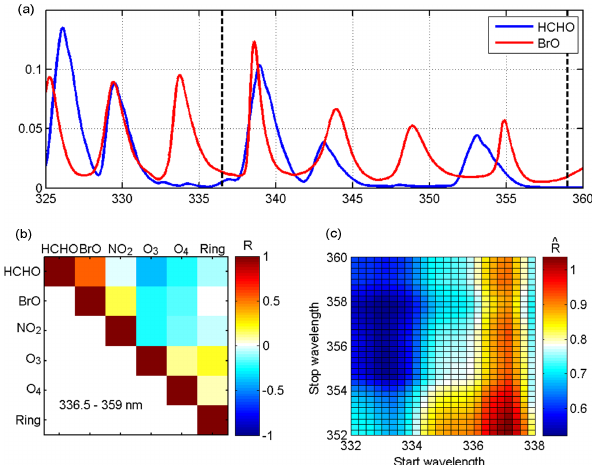
Fig. 15. (a) HCHO and BrO absorption cross sections in the 325– 360nm wavelength range convolved at the resolution of the BIRA instrument (0.38nm FWHM) and normalized in arbitrary units. (b) Correlation matrix of the absorption cross sections used for HCHO DOAS retrievals in the 336.5–359nm interval. (c) Overall correlation (expressed as the root mean square of the non-diagonal elements of the correlation matrix) for different wavelength inter- vals in the 332–360nm wavelength